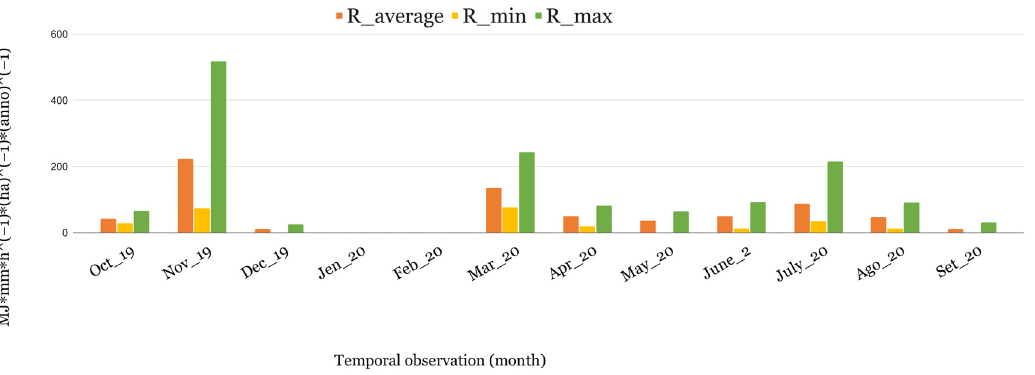
Figure 3. Histogram of the trend in R values during the months of analysis (October 2019 to September 2020).